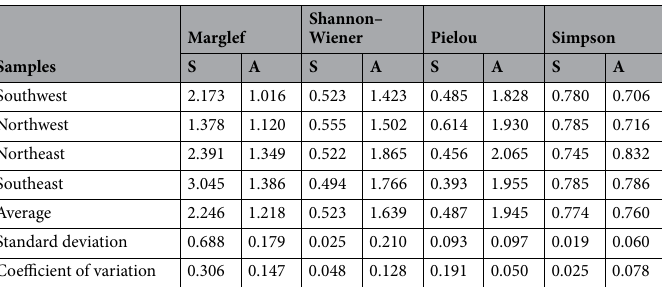
at different bottom positions, reflecting certain spatial heterogeneity of illumination, soil, humidity, and wind speed at different bottom positions.